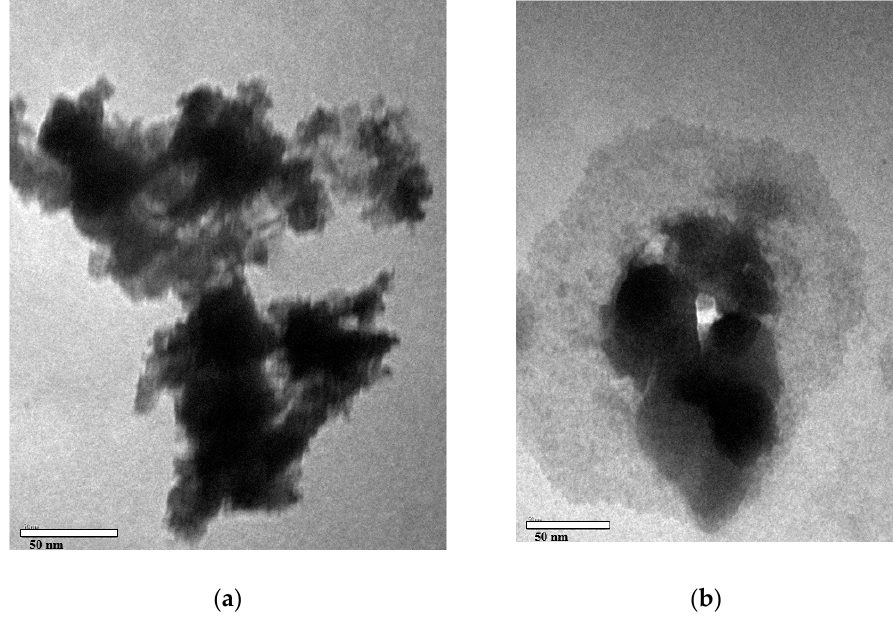
Figure 4. TEM photograph of ( a ) catalyst 1; ( b ) catalyst 1 (treated in basic solution).